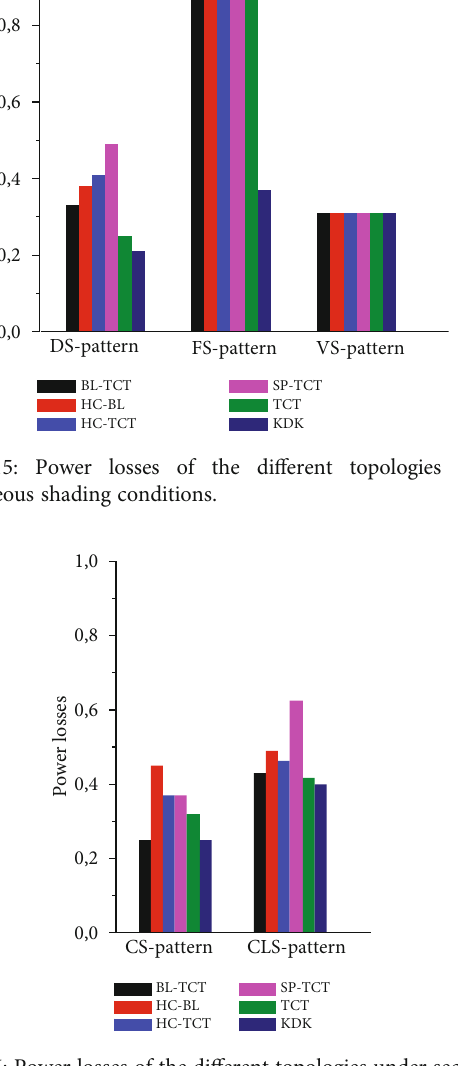
Figure 16: Power losses of the di ff erent topologies under sectional shading conditions.